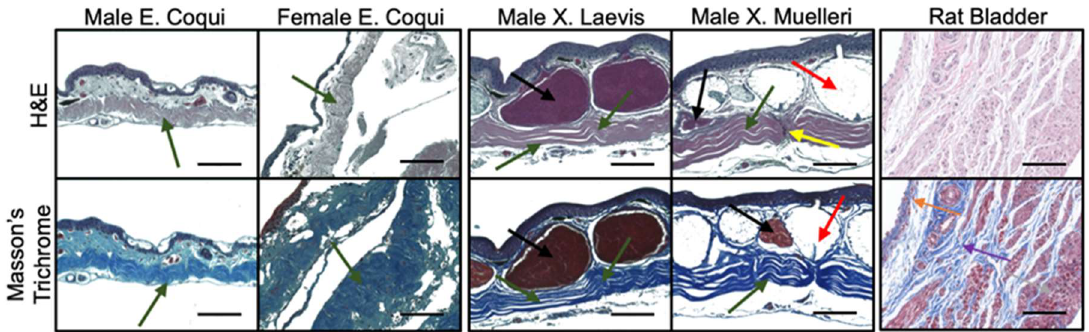
Figure 4. Hematoxylin and eosin (H&E) staining of leg tissue dissected from various species of frogs. Scale bar 100 µm. Muscle bundles (black arrows), mucous glands (red arrows), collagen structure (green arrows), perpendicularly aligned collagen (yellow arrows), urothelium (orange), lamina propria (purple), and detrusor muscle (grey).